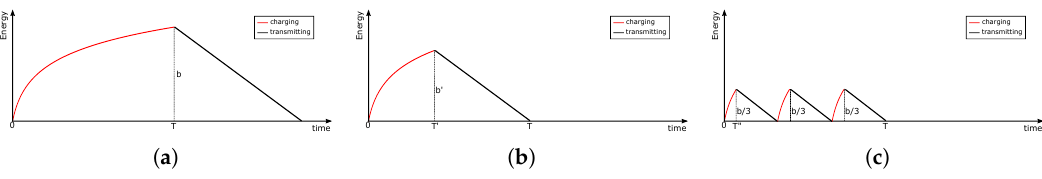
Figure 7. Find the maximum transmitted amount of data. ( a ) receive energy in the entire period of time T ; ( b ) receive energy for a shorter period of time T (cid:48) to transmit data; ( c ) receive energy for a more shorter period of time T ” to transmit